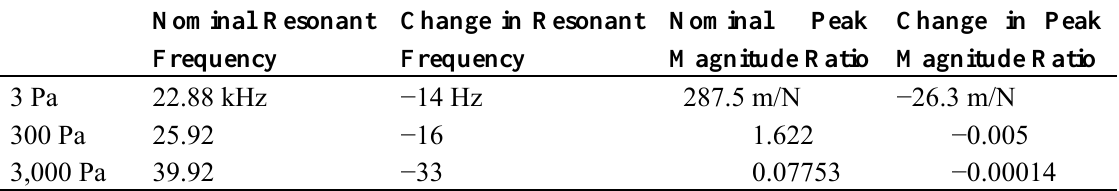
Table 2. Effect of the addition of nerve gas analog on resonant frequency and peak height